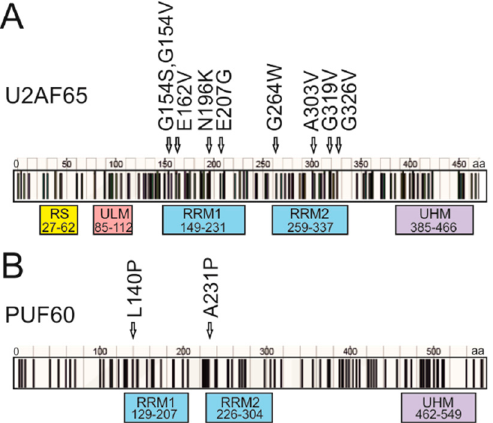
Figure 2. Distribution of cancer-associated substitutions in U2AF65 and PUF60. ( A , B ) Distribution of somatic missense mutations in the COSMIC database (v. 83). Their frequency is not shown since the COSMIC data could not be corrected for redundant entries, such as repeat samples from the same patient. PUF60 and U2AF65 substitutions that affected pre-mRNA splicing of our tested reporters are shown by arrows above RRM domains. (A) U2AF65. (B) PUF60. RRM alignments with tested